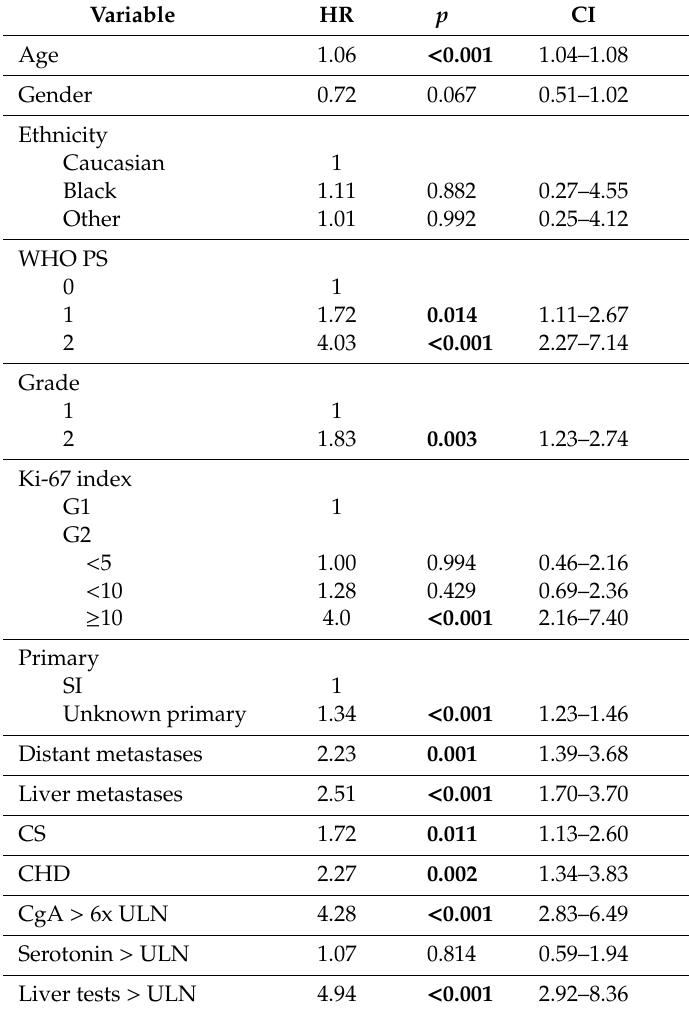
Table 2. Univariable analysis for disease specific